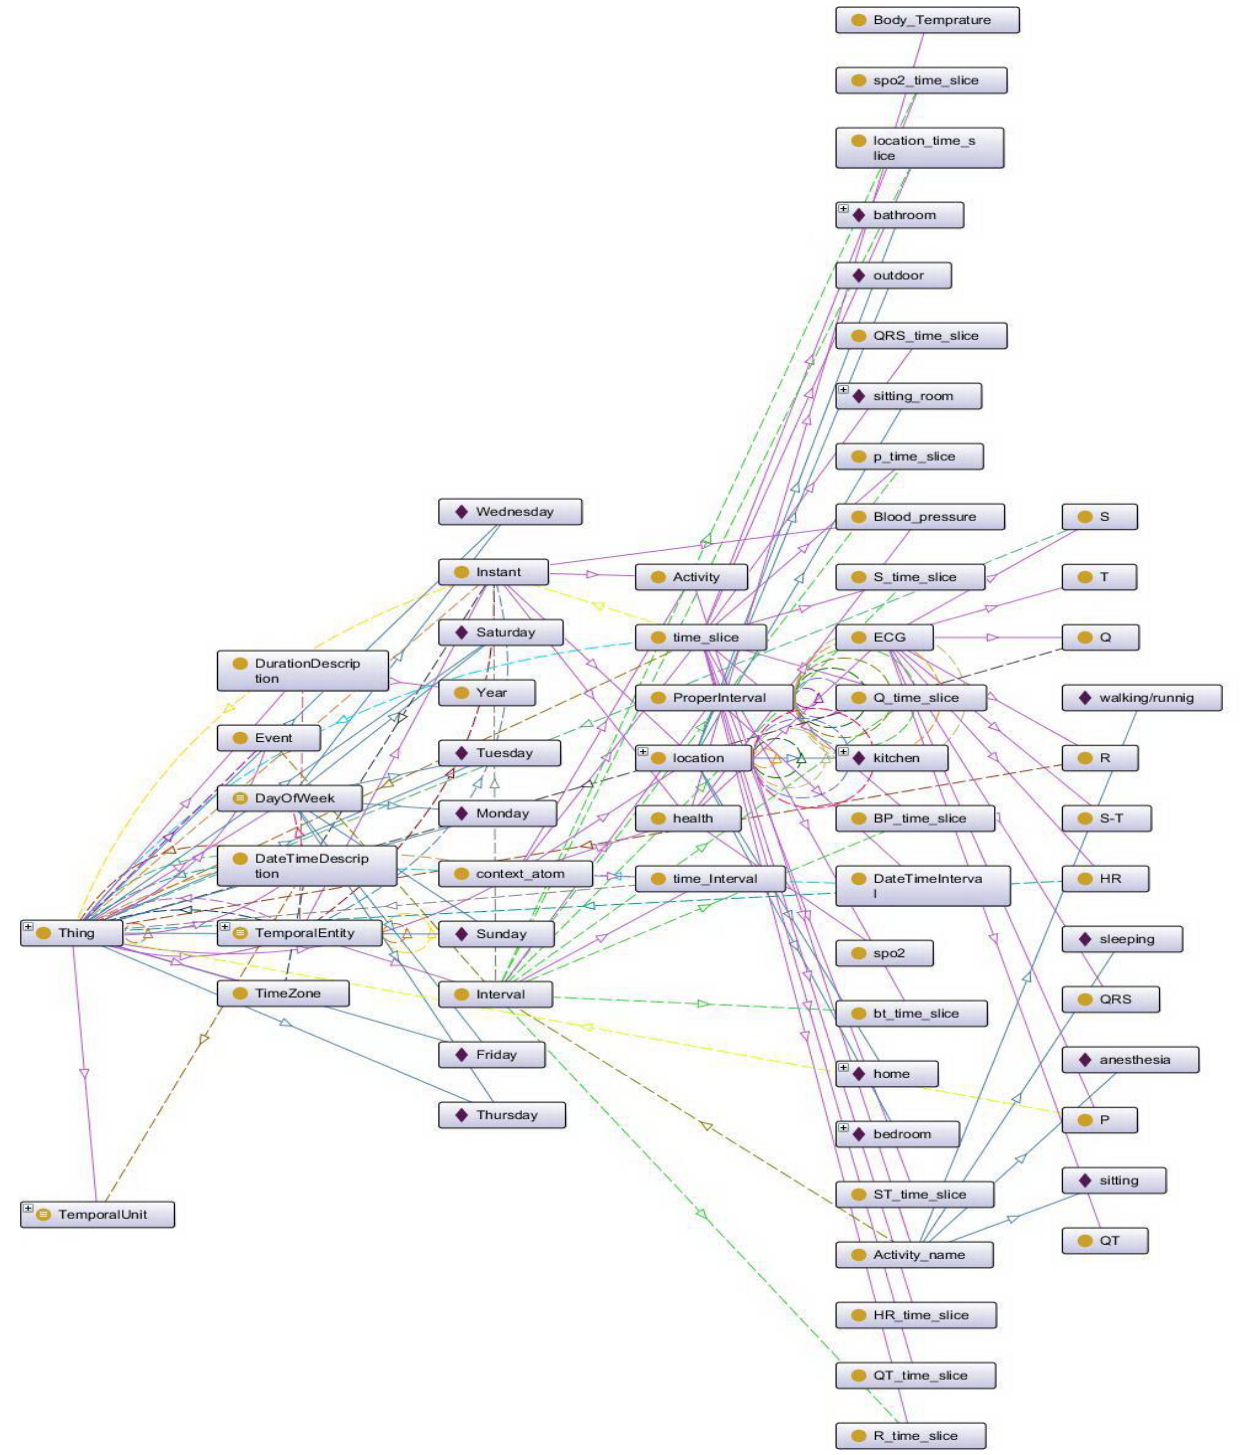
Figure 8.Graphic display of the context-aware